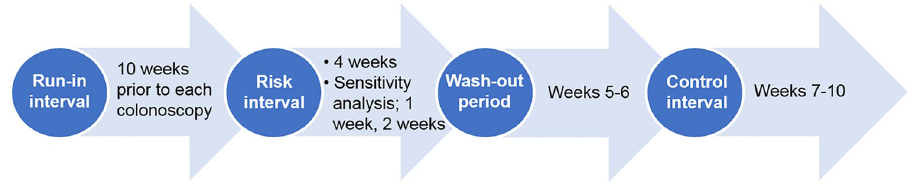
Fig 1. Diagram of self-controlled risk-interval study design in relation to